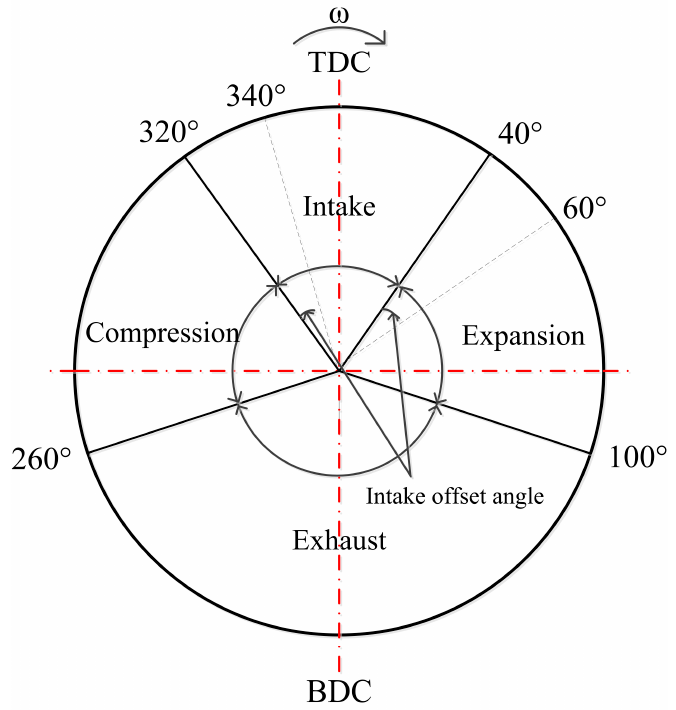
Figure 10. Valve timing diagram of the expander.